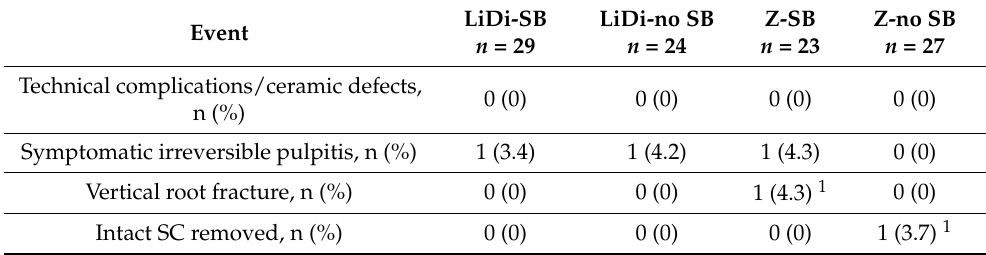
Table 2. Tooth- and restoration-related events in study groups. LiDi: lithium disilicate, Z: zirconia, SC: single crown, SB: sleep